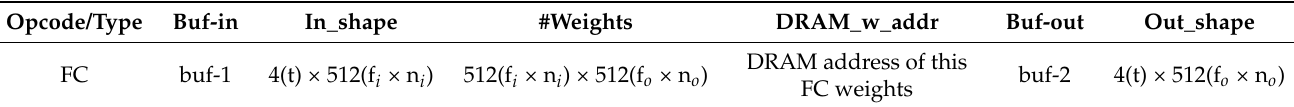
Table 8. Parameters of an example FC operation in Figure 2.